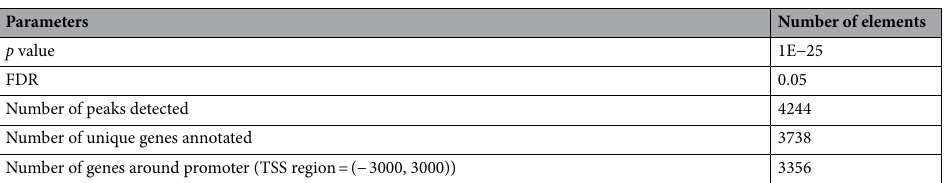
Table 3. Basic statistics describing in-house ChIP-seq outcome. Peaks that could be assigned to the nearest genes (i.e. +/− 3 kb around TSS region) were used for downstream analysis. The estimated fragment size is 157